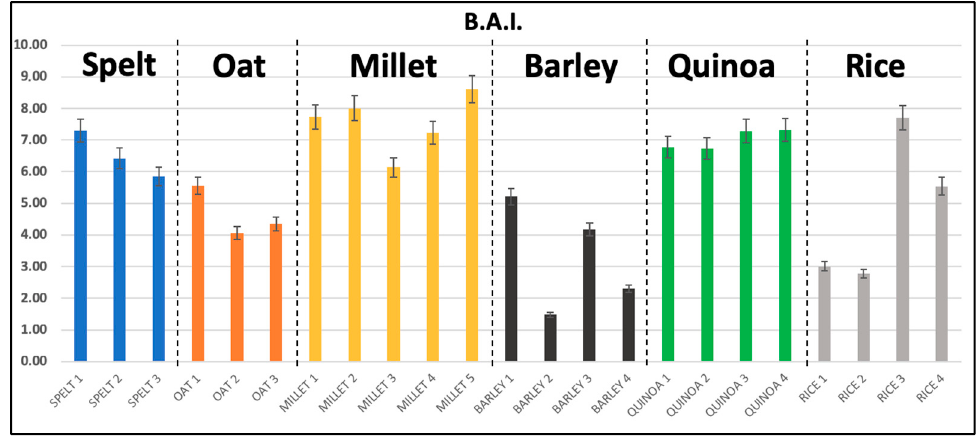
Figure 4. Biogenic Amine Index.